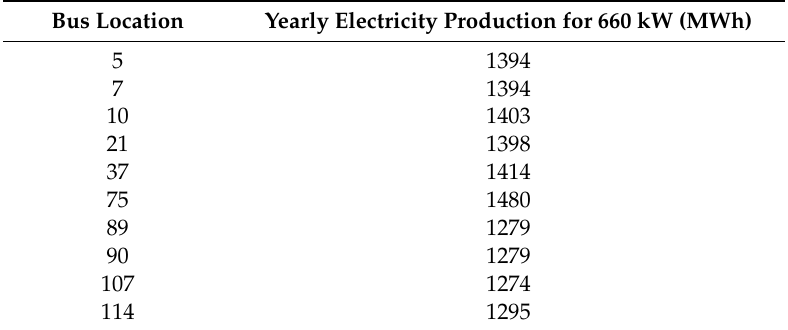
Table 5. Yearly electricity production for 660 kW of the wind turbine DG